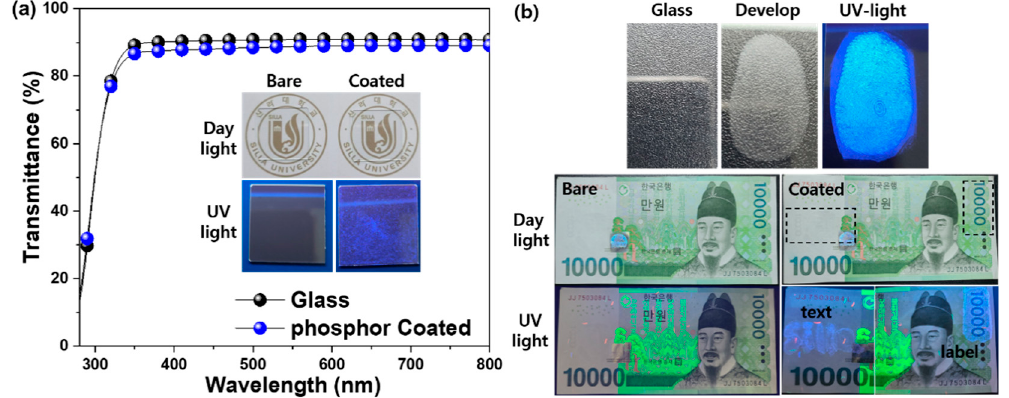
Figure 6. ( a ) Transmittance of Ce 3+ -doped h-BN nanophosphors coated on glass and ( b ) images of Ce 3+ -doped h-BN nanophosphors fingerprinting development on glass substrate (up) and painted on Korean bank notes (down); used samples were re-heated at 1400 °C.